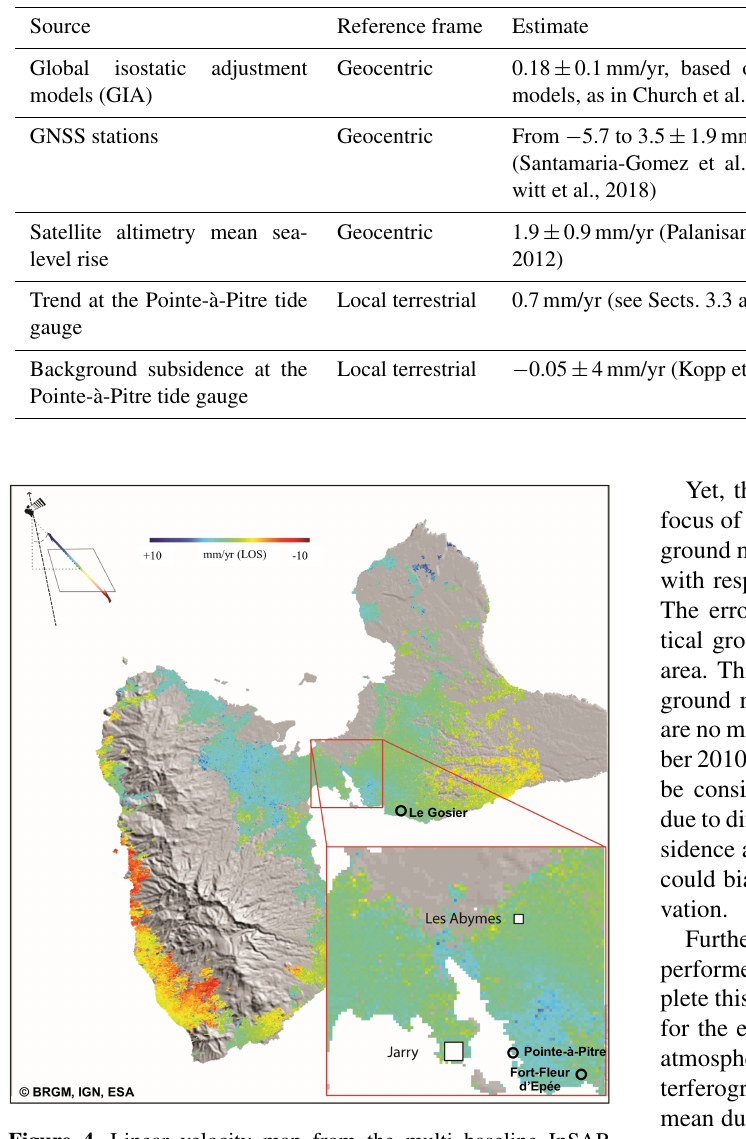
Figure 4. Linear velocity map from the multi baseline InSAR method. These results are based on the analysis of 34 radar scenes acquired between 2003 and 2010 by the ASAR sensor on Envisat of the European Space Agency (map created by BRGM; data: IGN, ESA; © BRGM, IGN,